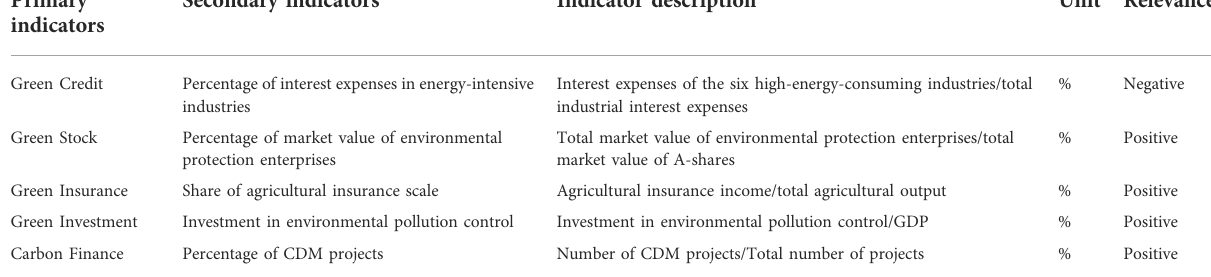
TABLE 1 Green fi nance indicator evaluation